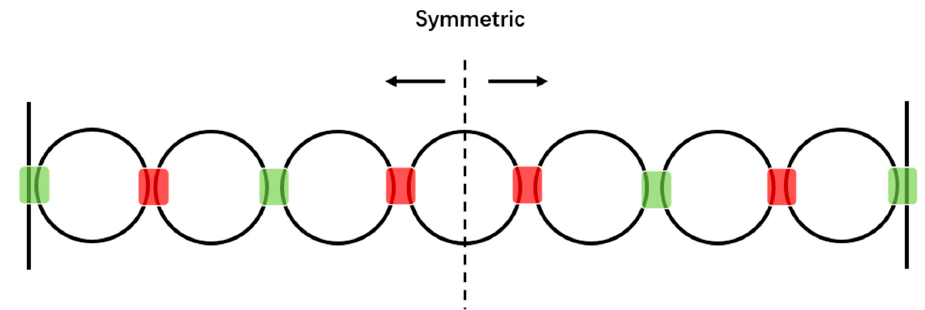
Figure 7. The schematic diagram of the proposed modulation scheme for evanescent coupling. The green and red represent strong and weak coupling between resonators which alternates between weak (green) and strong (red) coupling or vice versa symmetrically about the center resonator.